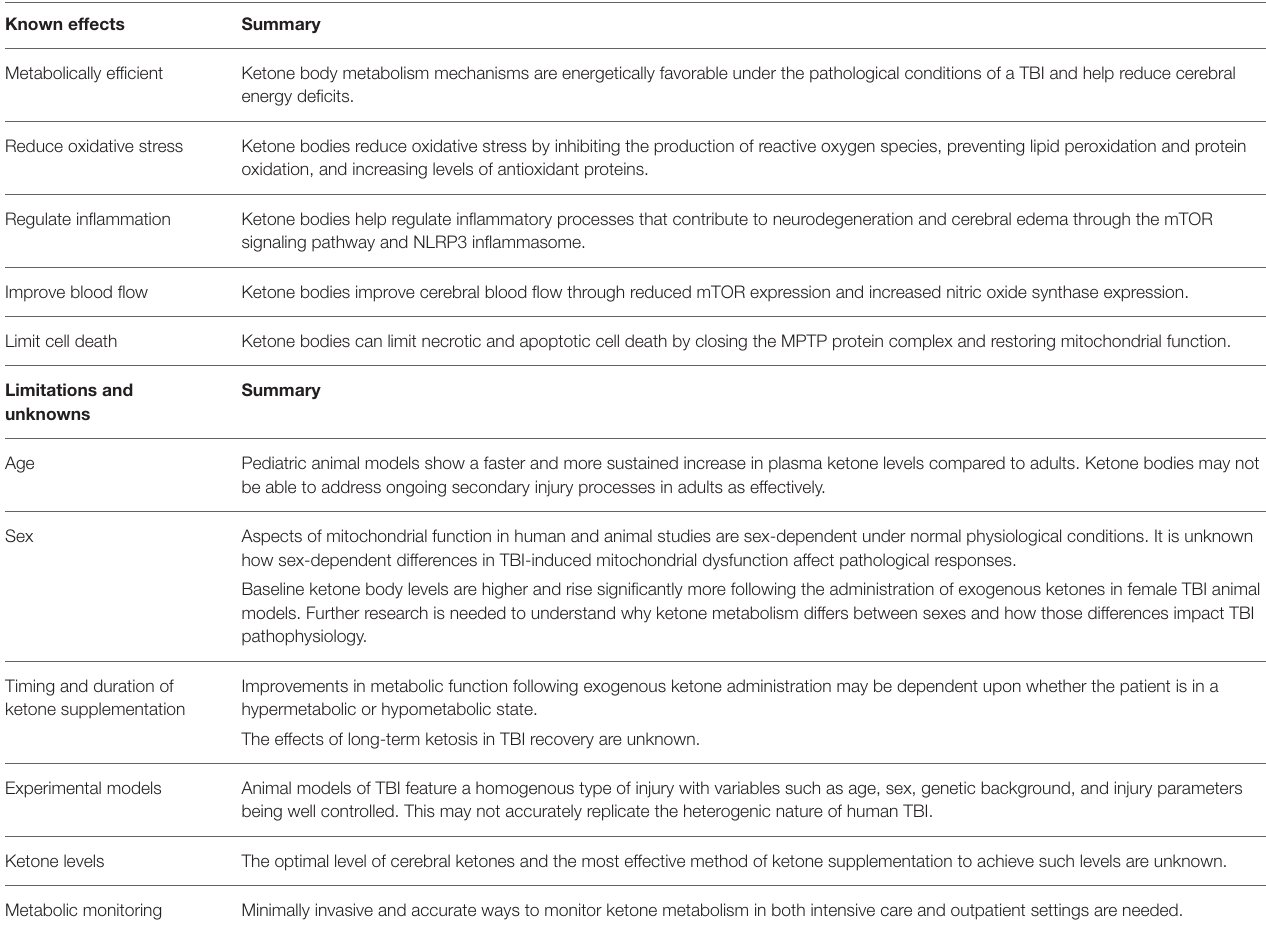
TABLE 2 | A summary of the current state of knowledge of ketone therapy in TBI treatment, including known effects, limitations, and